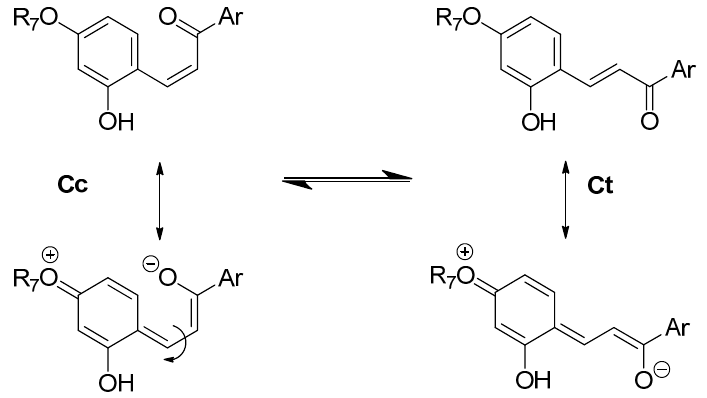
Figure 12. Electron donation from the substituent at C7 (R 7 = H, Me, Glc) and its accelerating effect on cis - trans chalcone isomerization.